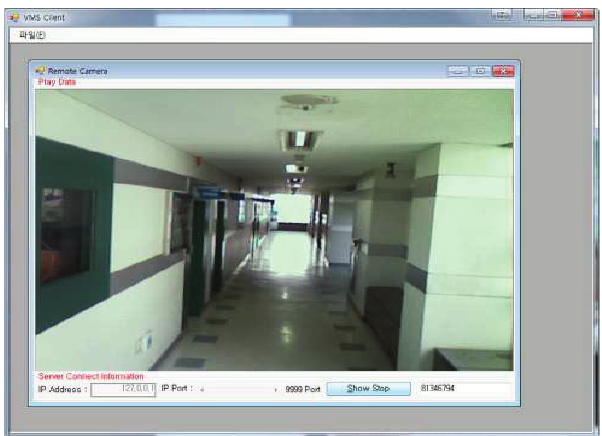
Figure 9: VMS Client implementation.